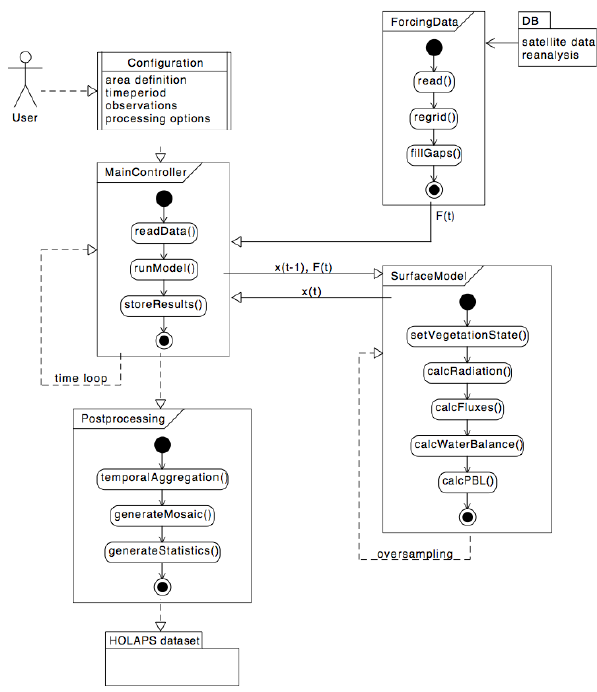
Figure B1. HOLAPS runtime